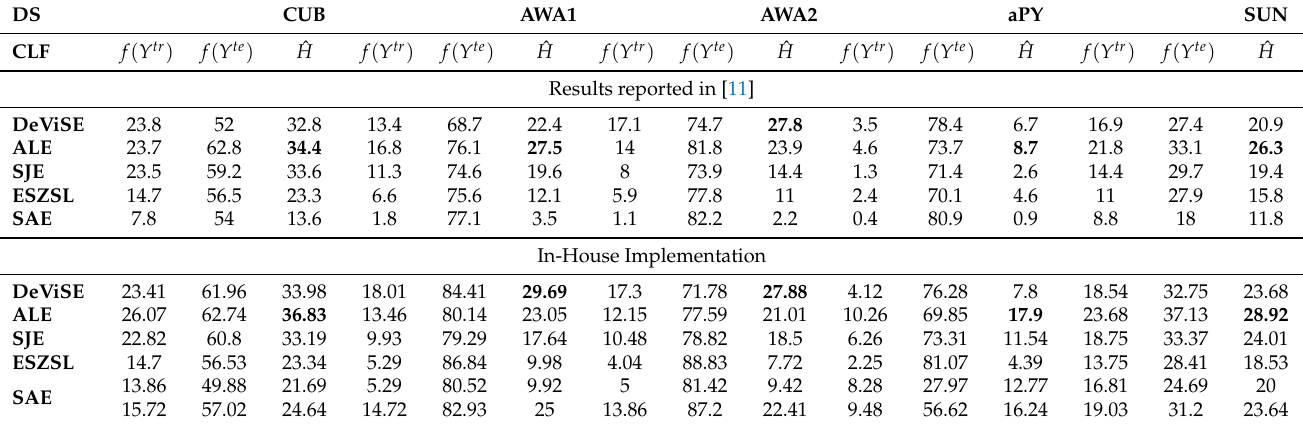
Table 4. Individual Classifier Results for the Top-1